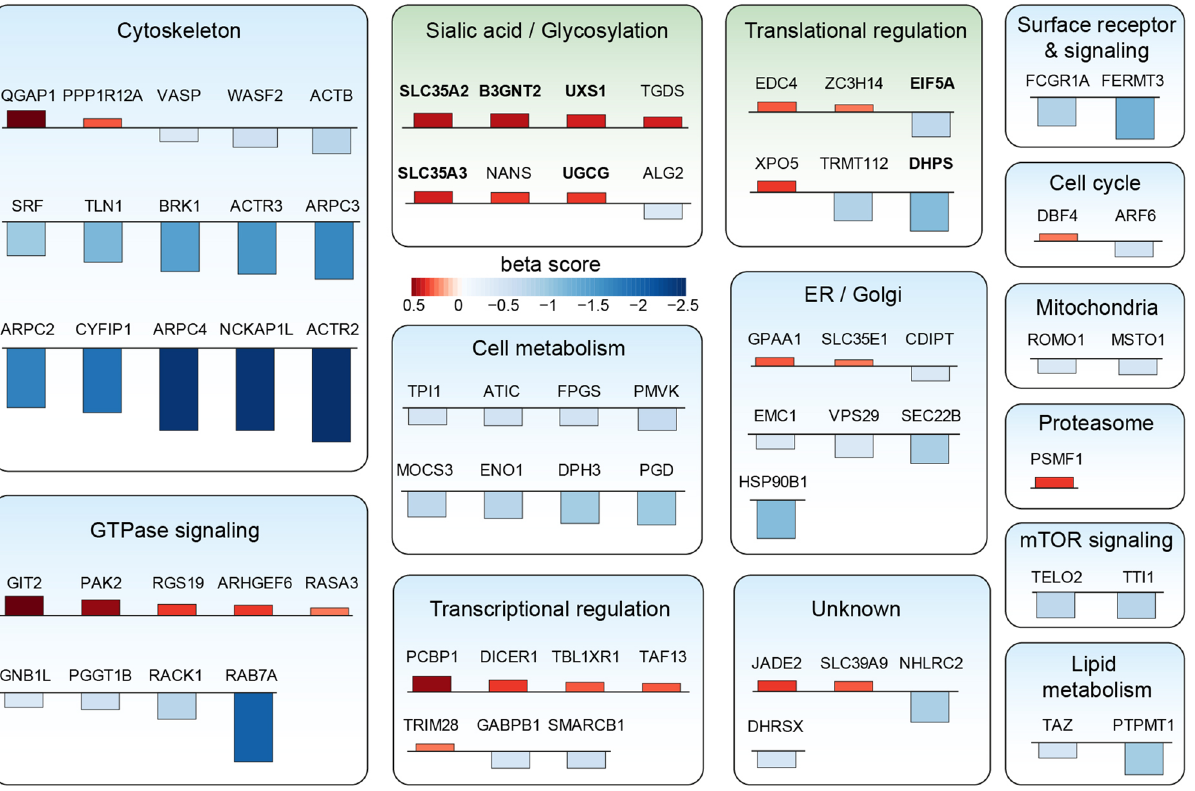
Figure 3. Functional classification of high confidence hits. The 75 high confidence hits were classified according to their function using GO terms and literature search. The direction of the bars indicates the sign of the beta score and the color and height indicates the value. Negative and positive beta values indicate genes whose knockout impairs or activates phagocytosis, respectively. Genes in bold are selected for single gene knockout